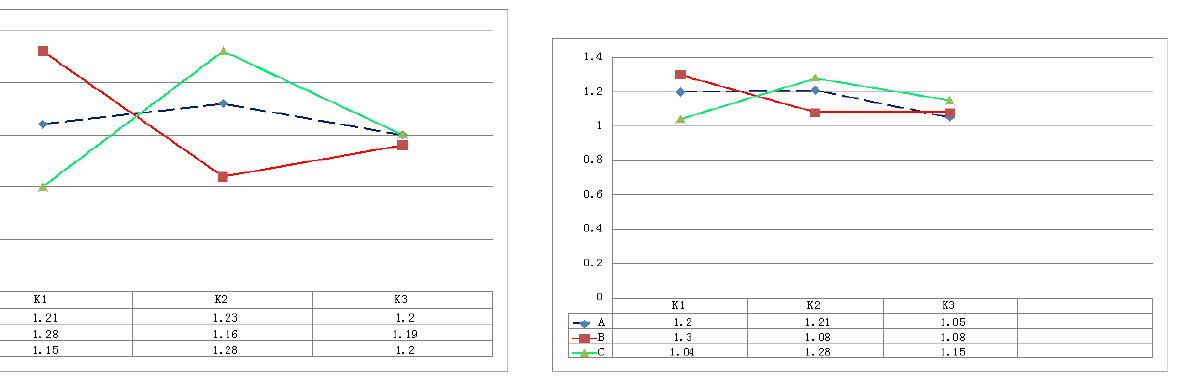
Figure 8: Relationship between factors, levels, and K values (steel